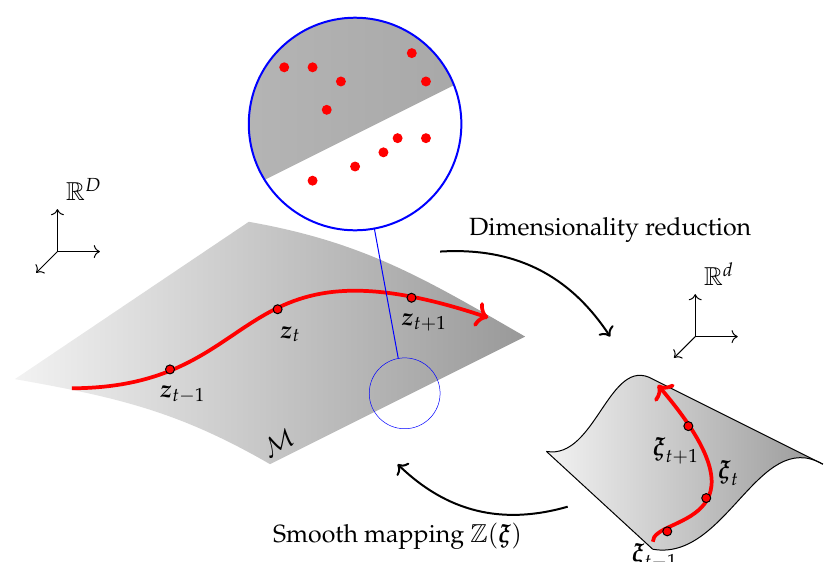
Figure 1. Hypothesis about the existence of a constitutive manifold in which the experimental results live. Despite the noise in the data, Topological Data Analysis (TDA) techniques will help us in unveiling the true geometry of the manifold in the high-dimensional setting, which will later be embedded onto a low dimensional space for the ease of